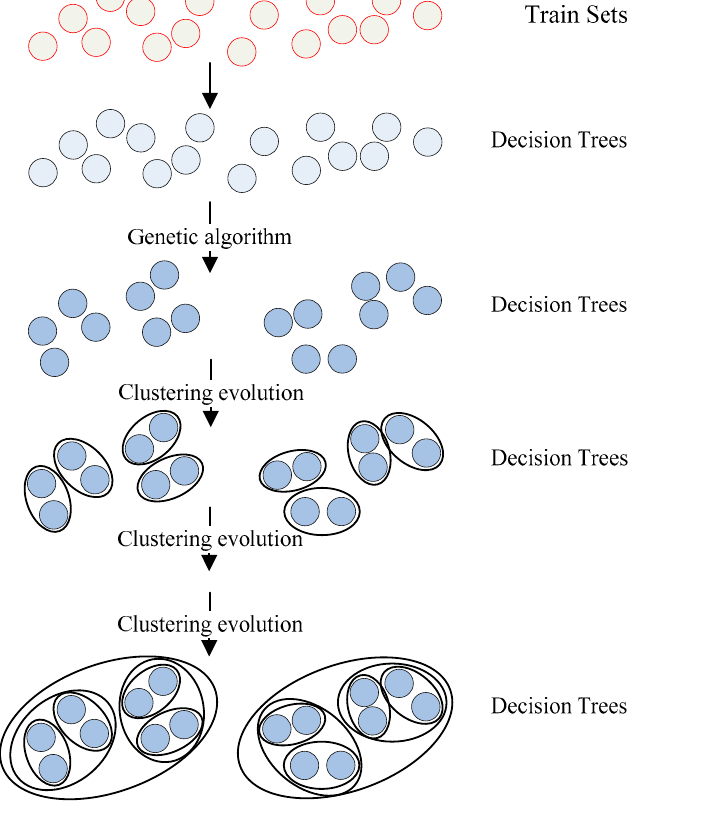
Figure 3. The schematic diagram of genetic clustering random forest. Genetic algorithm and clustering evolution were applied to increase the difference among basic classifiers and further improve their diversity and accuracy.